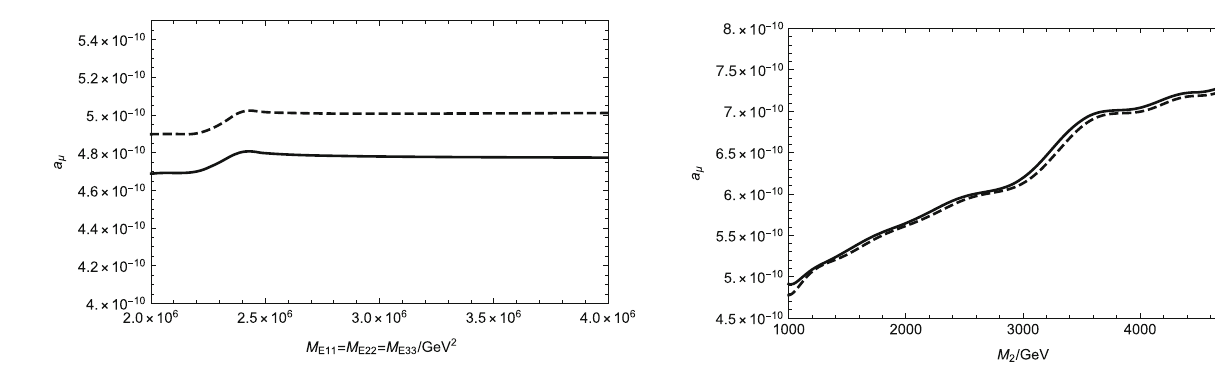
Fig. 7 The effect of M 2 on the results. The dashed line expresses v S = 3800 GeV, and the solid line expresses v S = 4300 GeV 7.